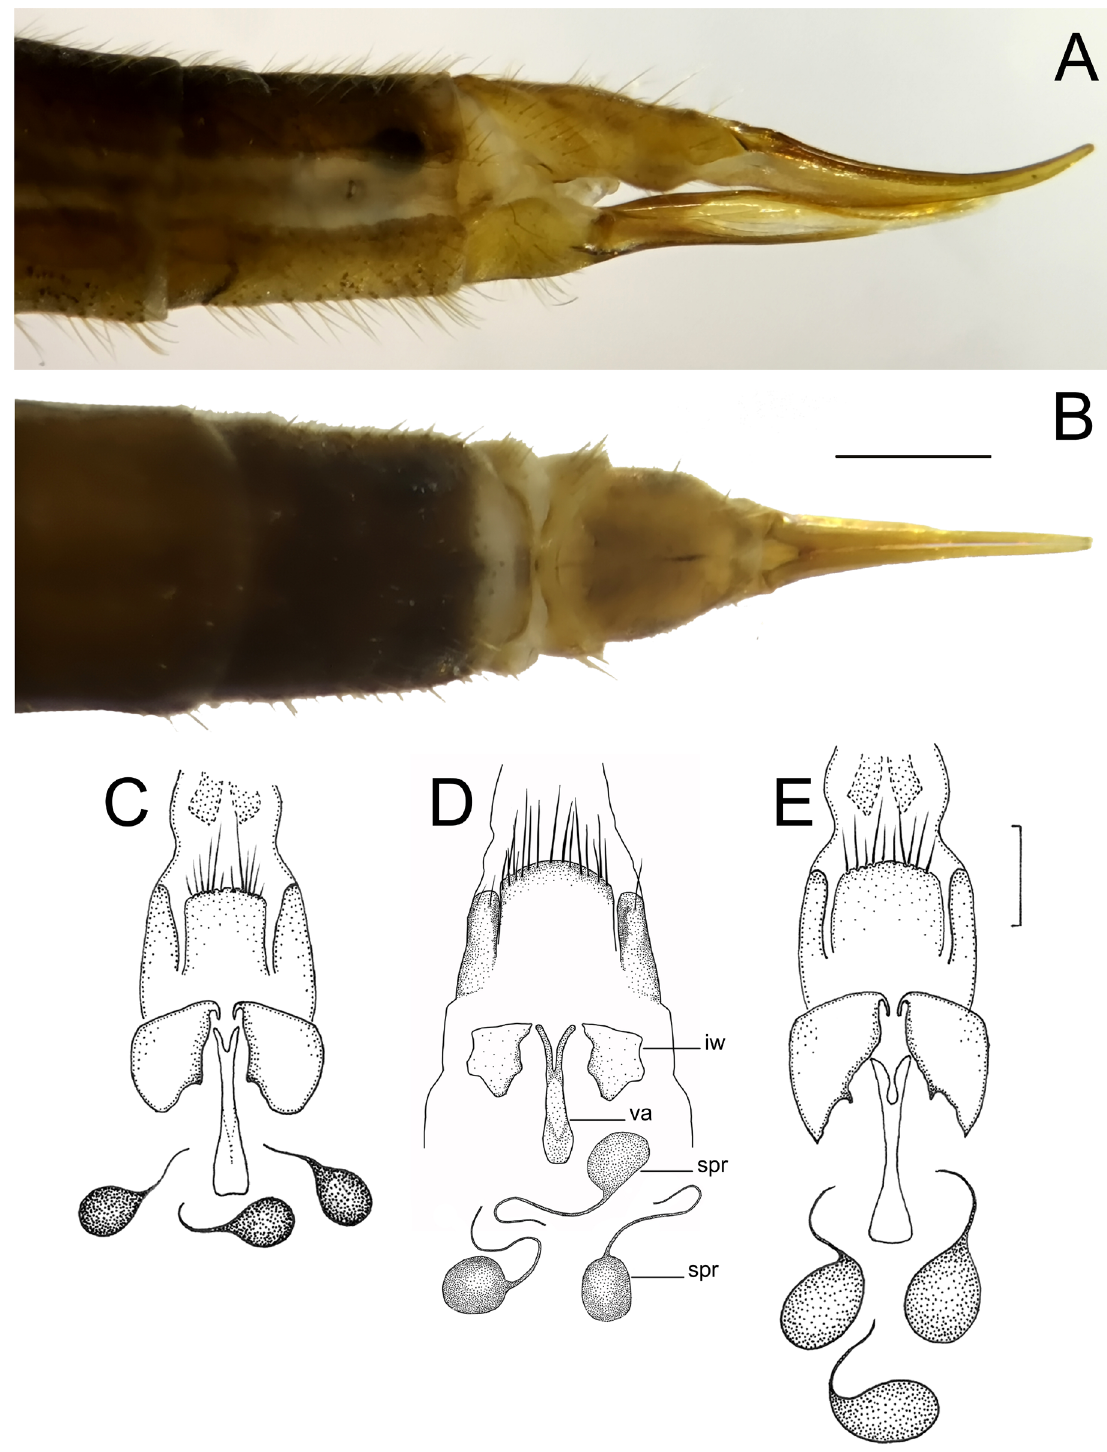
Fig. 5. A–B . Female terminalia of Dicranophragma (B.) relictum Mederos sp. nov. A . Lateral view. B . Dorsal view. C–E . Comparison of the internal structures of female terminalia of three Dicranophragma species (ventral view). C . D. (B.) adjuntum (Walker, 1848). D . D. (B.) relictum Mederos sp. nov. E . D. (B.) nemorale (Meigen, 1818). Abbreviations: see Material and methods. Scale bars = 0.25 mm (images C and E after Starý & Reusch